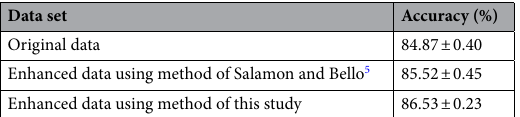
Table 2. Engine sound recognition accuracy before and after data enhancement.